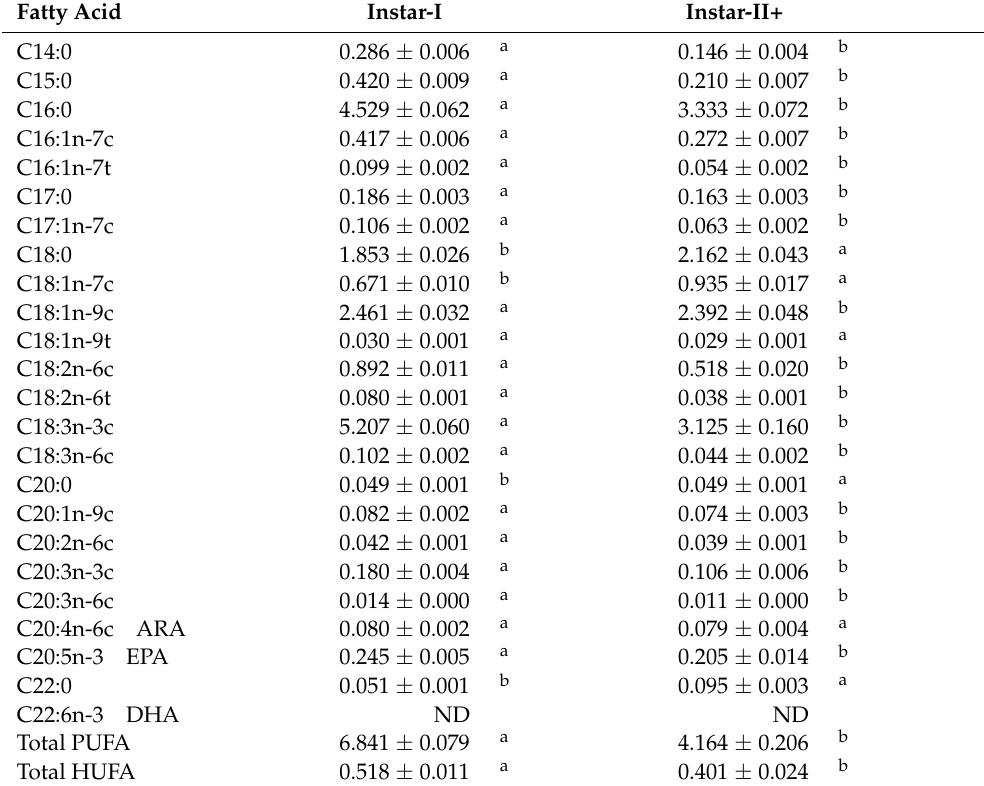
Table 2. Mean percent fatty acid composition ( ± SE) of total dry weight of instar-I and enriched